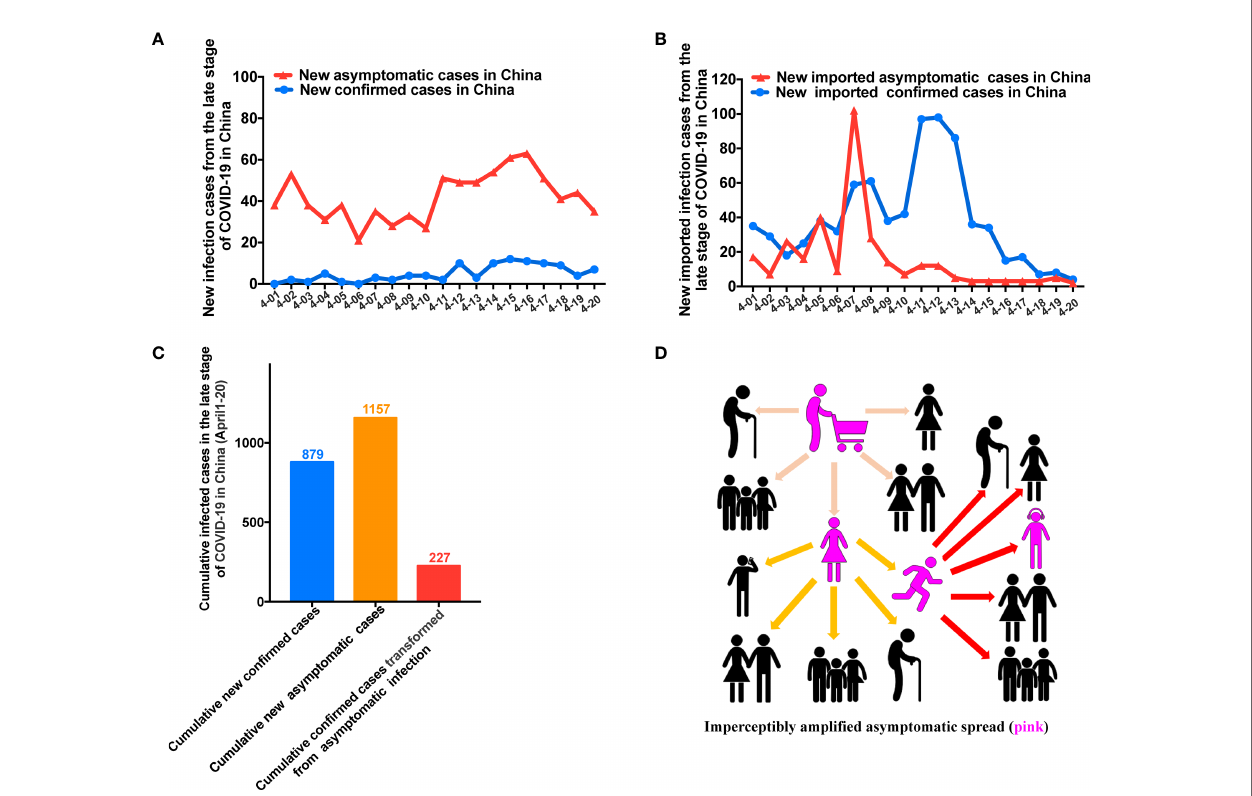
FIGURE 5 | China curbed asymptomatic spread in its late stage of COVID-19. (A) Most cases of COVID-19 in the late phase of the pandemic in China were asymptomatic. (B) The rate of asymptomatic infection among imported cases in the late stage of the pandemic in China was relatively high. (C) Among the newly diagnosed cases, a higher proportion exhibited asymptomatic infection in the late phase of the pandemic in China than in the early phase. (D) Asymptomatic infection (pink) can lead to imperceptible subexponential or exponential